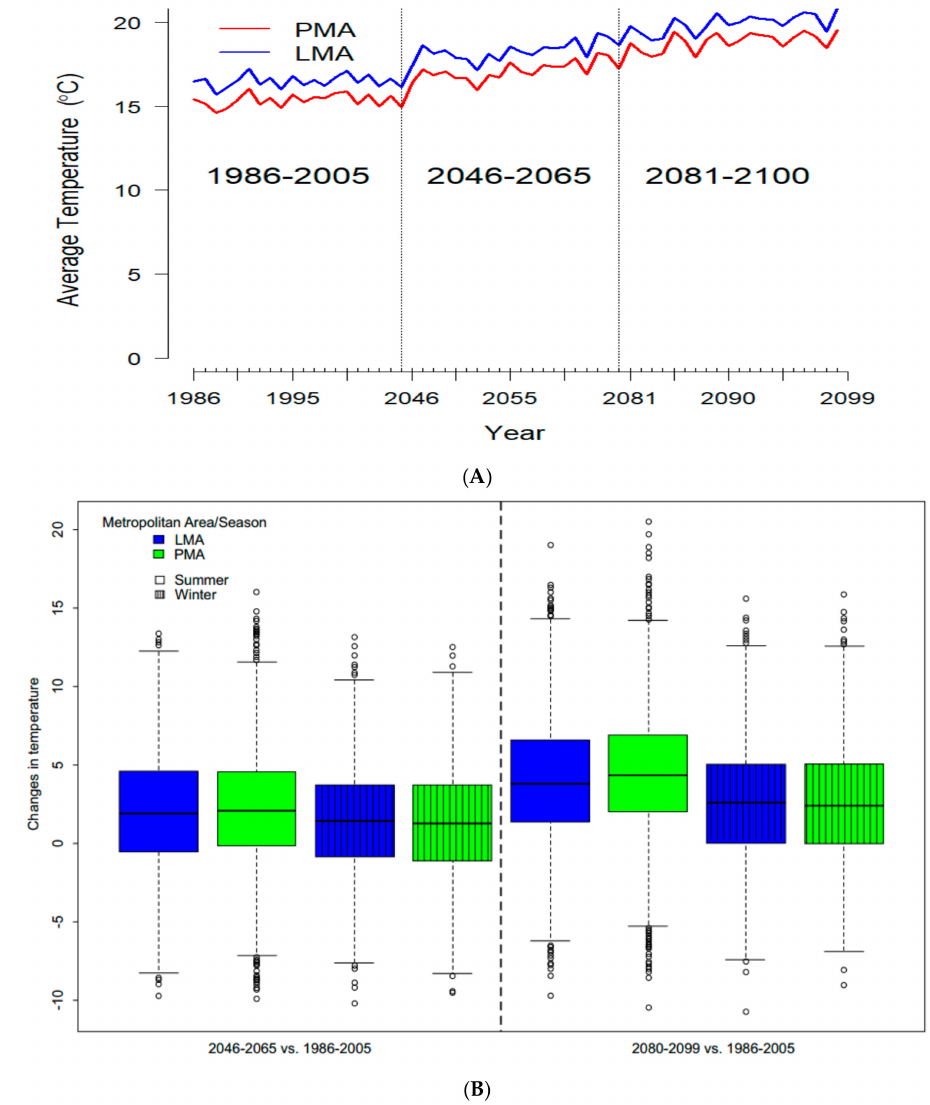
Figure 2. Distribution of mean temperature in the historical period (1986–2005) and future periods (2046–2065 and 2080–2099). ( A ) Time series of temperature for the study period, ( B ) Changes in mean daily temperature for winter and summer seasons. The Representative Concentration Pathway (RCP8.5) greenhouse gas emission scenario is